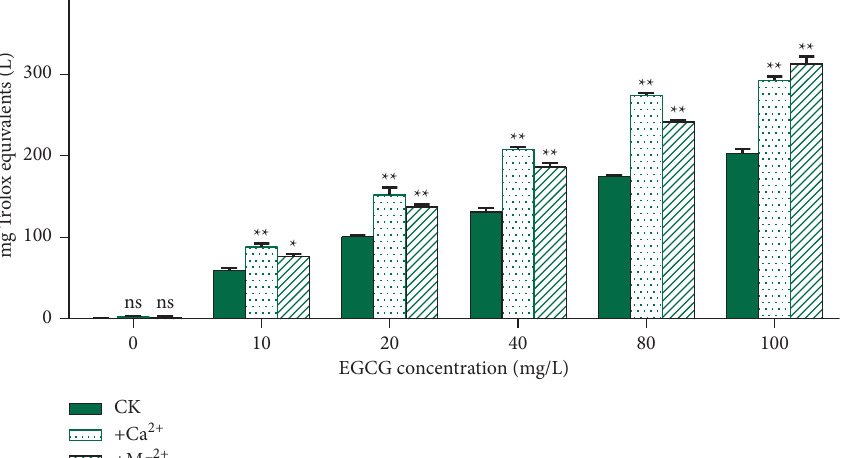
Figure 5: Effect of Ca 2+ and Mg 2+ of 40mg/L on the antioxidant activity of EGCG solutions with different concentrations. CK: control check, EGCG solution without ion; +Ca 2+ : EGCG solution with Ca 2+ ; +Mg 2+ : EGCG solution with Mg 2+ . The marks above the column show the significance of differences between CK with +Ca 2+ or +Mg 2+ , ns indicates p > 0 . 05, ∗ indicates p < 0 . 05, and ∗∗ indicates p < 0 .